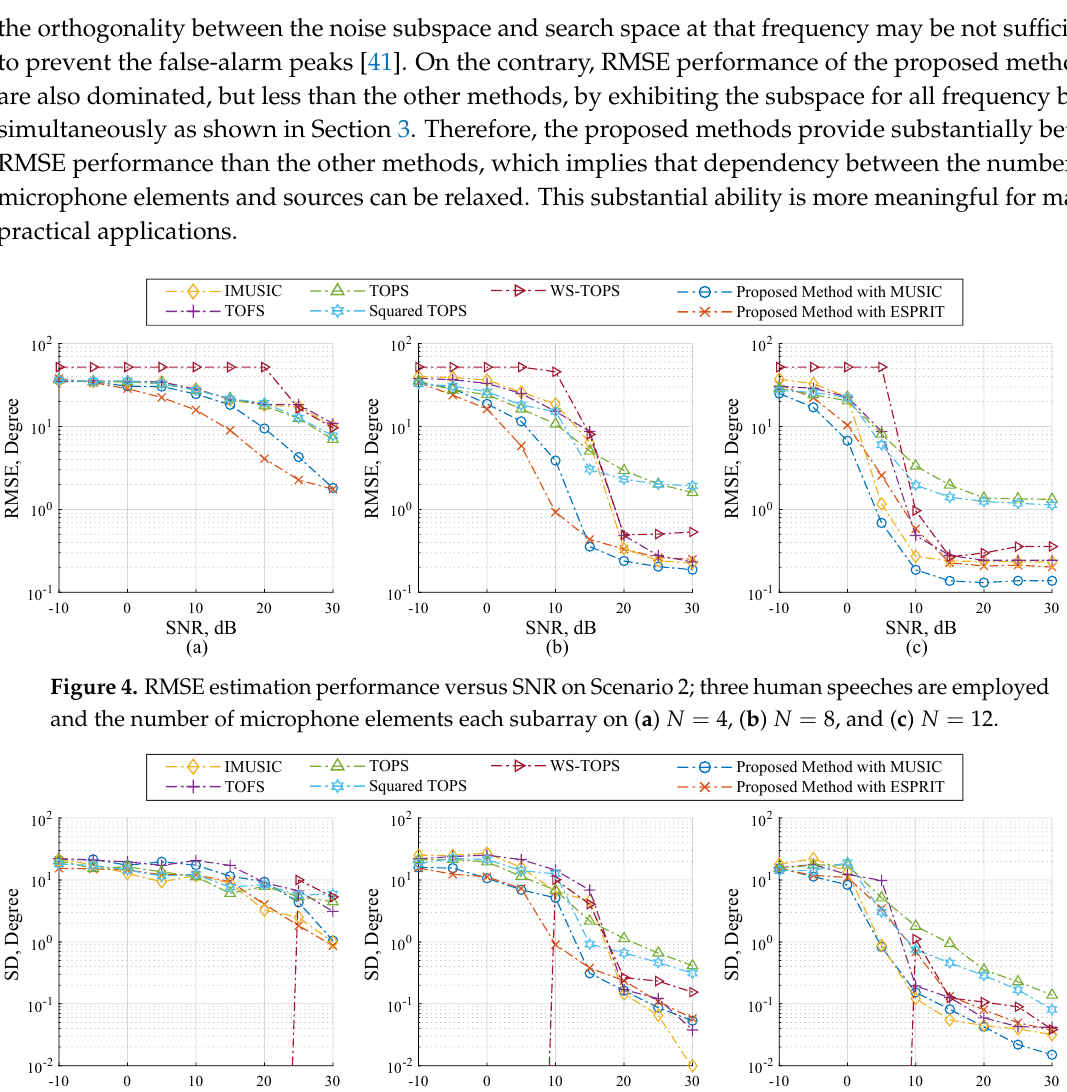
Figure 5. SD estimation performance versus SNR on Scenario 2; three human speeches are employed and the number of microphone elements each subarray on ( a ) N = 4, ( b ) N = 8, and ( c ) N =